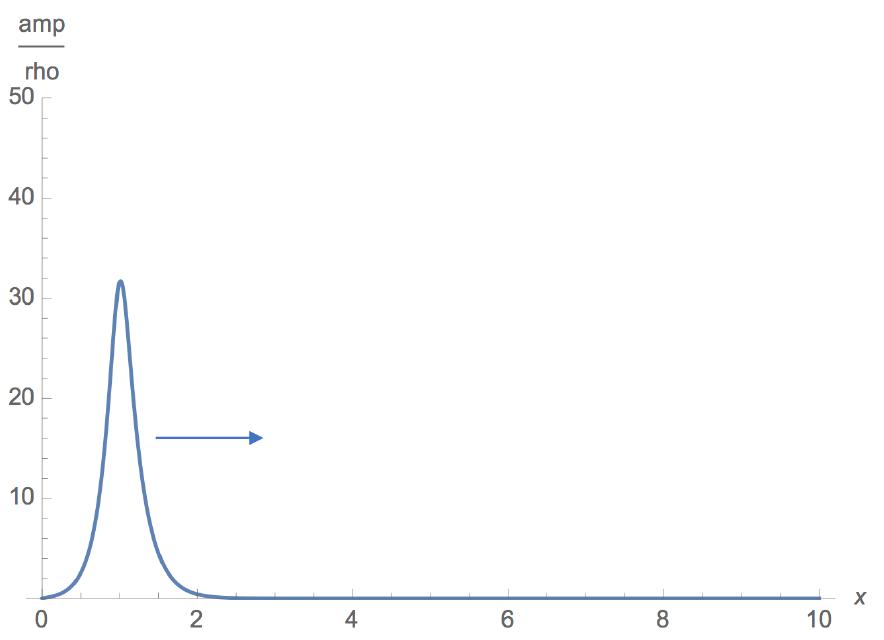
Figure 3. The shape and travel direction of the soliton in the case of plane geometry for ocean surface gravity waves. The x direction is toward the coast; vertical axes represent normalized wave